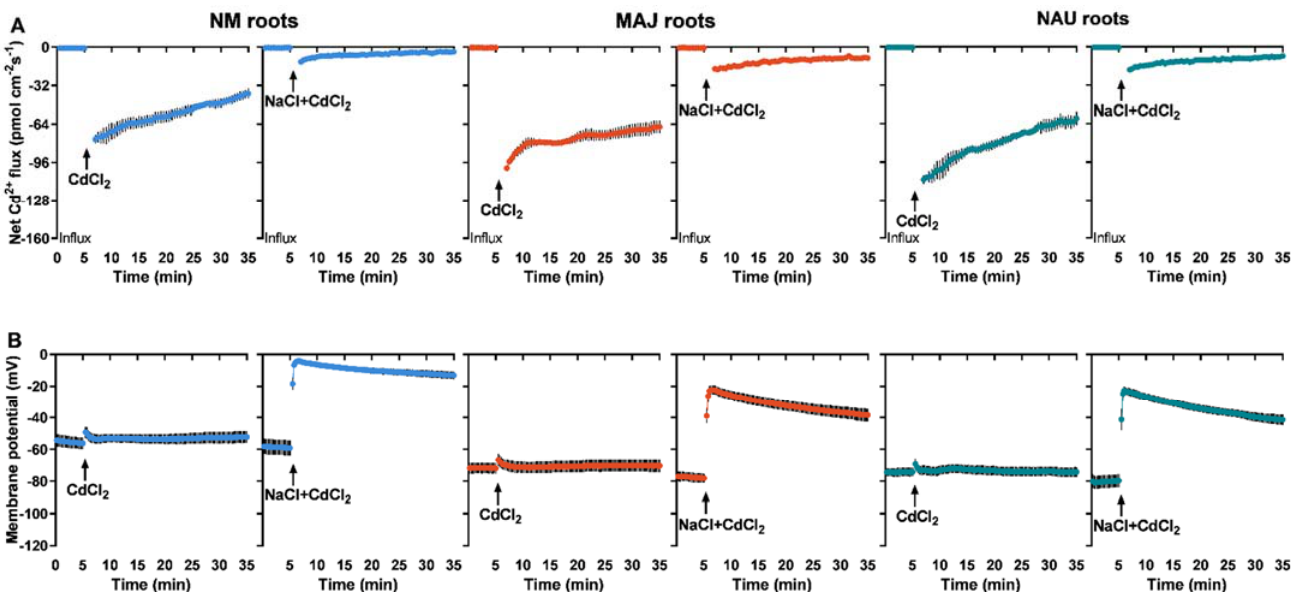
Figure 4. CdCl 2 and NaCl shock-altered Cd 2+ kinetics and membrane potential in non-mycorrhizal (NM) Populus × canescens and ectomycorrhizal (EM) roots. ( A ) Cd 2+ flux kinetics. ( B ) Membrane potential. Poplar plantlets were inoculated with or without Paxillus involutus isolates (MAJ or NAU) for 30 d. Root tips were excised from EM- and NM-poplars and equilibrated for 30 min in Cd 2+ or H + measuring solution. At the apical zones Cd 2+ fluxes and membrane potential were recorded before and after the addition of CdCl 2 (100 μ M) or a combined solution of CdCl 2 (50 μ M) and NaCl (100 mM). The recordings continued respectively for 5 and 30 min before and after the cadmium and salt shock. Each data point is mean ± SD obtained from 5 individual plants.